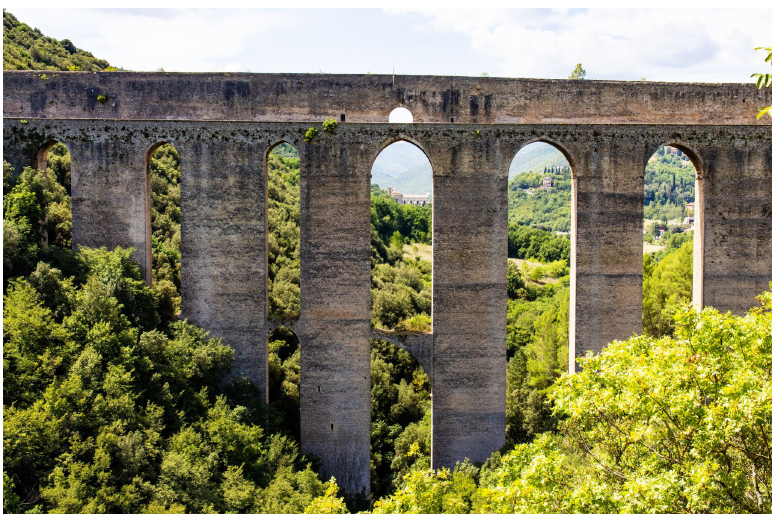
Figure 1. View of ‘Ponte delle Torri’.